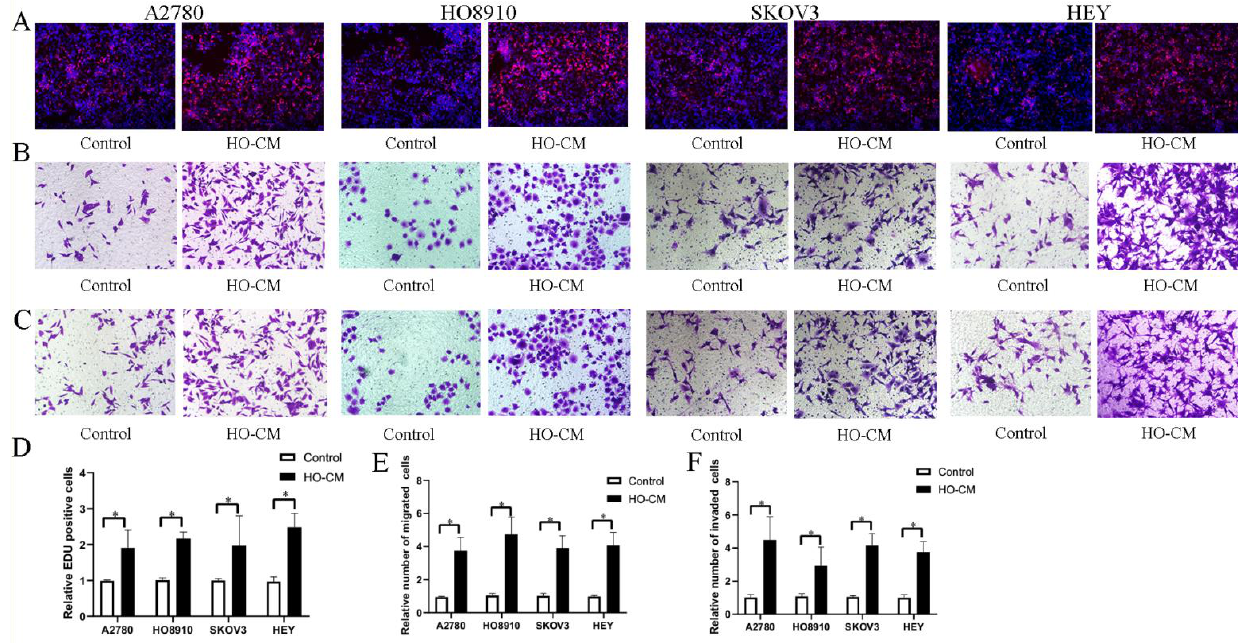
Figure 1. HO-CM increases human EOC cell proliferation, migration, and invasion (A2780, HO8910, SKOV3, and HEY) in vitro. ( A ). The effect of HO-CM on human EOC cell proliferation was measured by EdU assay. ( B ). The effect of HO-CM on human EOC cell line migration was measured by Transwell assay. ( C ). The effect of HO-CM on human EOC cell invasion was measured by Transwell assay. ( D ). Quantification of proliferation rates showed that the proliferative capacity of human EOC cell lines was significantly improved after HO-CM treatment. ( E ). Quantification of migrating cells showed that the migratory capacity of human EOC cell lines was significantly improved after HO-CM treatment. ( F ). Quantification of the invasion rates of human EOC cell lines showed that the invasive capacity of human EOC cell lines was significantly improved after HO-CM treatment. * p < 0.05, n =